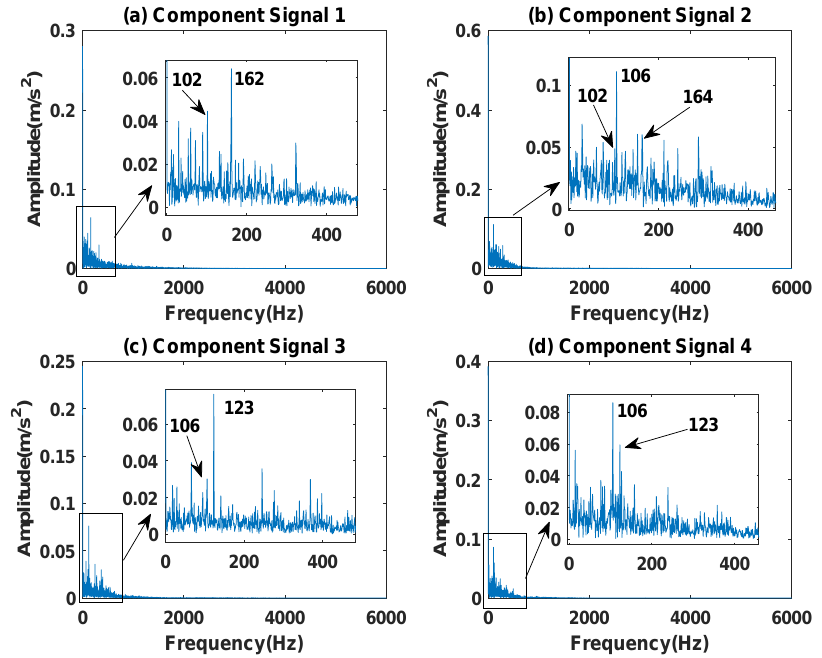
Figure 27. Decomposition results of VMD with m = 16: ( a – d ) envelop of 1st to 4th subcomponents,